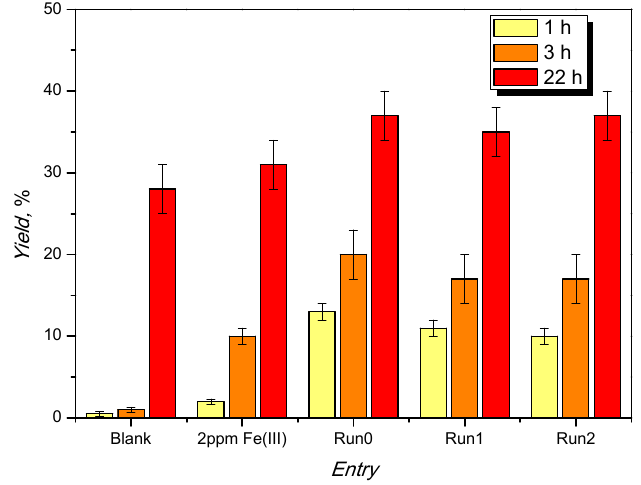
Figure 6. Evolution of the yield to ketal vs. the reaction time at 75 ◦ C for MIL-88A during the recycles, homogeneous Fe(III), and blank test.